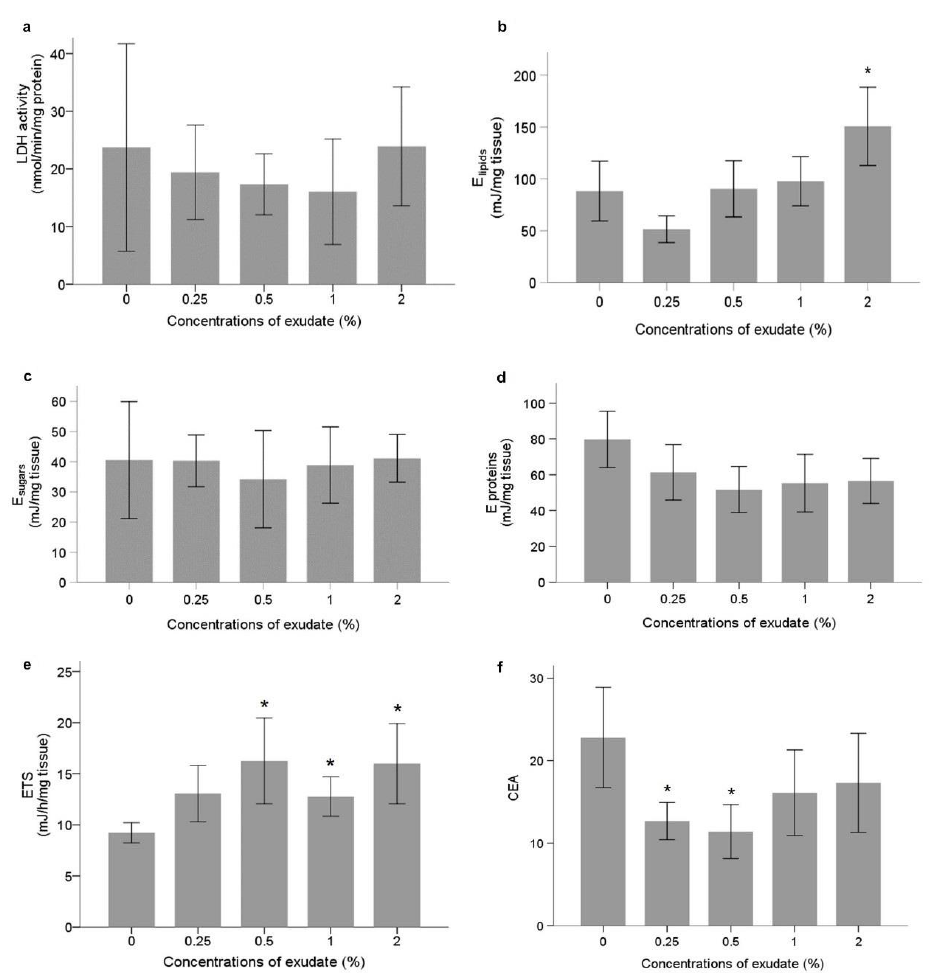
Figure 4. Energy metabolism biomarkers of M. galloprovincialis muscle after 96 h of exposure to A. armata exudate. ( a ) Lactate dehydrogenase (LDH); ( b ) Lipids content (E lipids ); ( c ) Sugars content (E sugars ); ( d ) Proteins content (E proteins ); ( e ) Electron transport system (ETS); ( f ) Cellular energy allocation (CEA). All values are presented as mean ± SE. * denotes a statistically significant difference compared to control (0%).